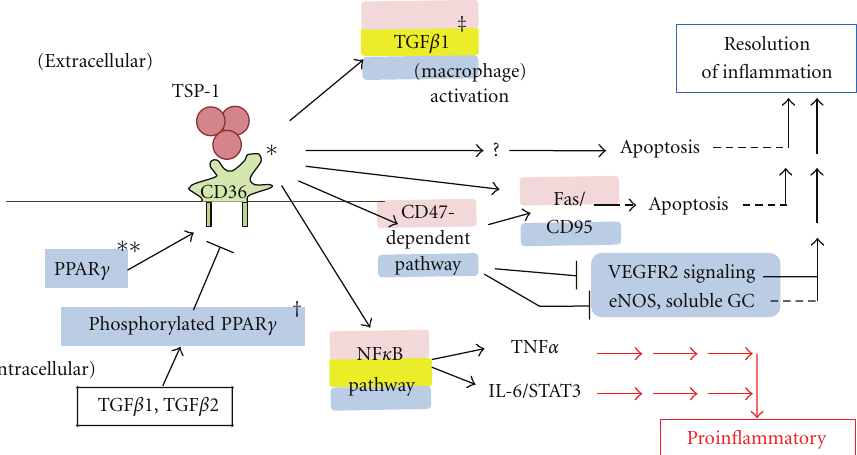
Figure 2: Dual role of CD-36—TSP-1 interaction in inflammation. Expression of CD36 is positively regulated by PPAR γ and negatively regulated by TGF β . As an integral membrane protein, CD36 binds many ligands including TSP-1. The CD36-TSP-1 interaction involves conformational changes in TSP-1. This interaction mediates apoptotic e ff ects via the CD47-dependent pathway, which has multiple e ff ects. The CD36-TSP-1 interaction can also activate macrophage TGF β 1 and the NF κ B pathway ∗ [98, 99], ∗∗ [100–102], † [100], ‡ [103]. Blue shading indicates pathways occurring in endothelial cells, pink shading in macrophages, and yellow shading in epithelial cells.